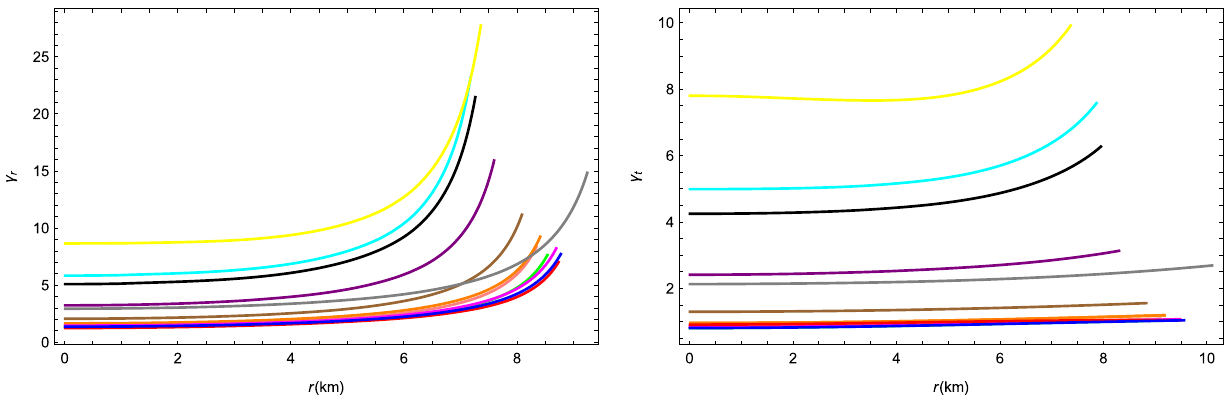
Fig. 10 Variation of γ r , and γ t of S 1 ( (cid:2) ), S 2 ( (cid:2) ), S 3 ( (cid:2) ), S 4 ( (cid:2) ), S 5 ( (cid:2) ), S 6 ( (cid:2) ), S 7 ( (cid:2) ), S 8 ( (cid:2) ), S 9 ( (cid:2) ), S 10 ( (cid:2) ), S 11 ( (cid:2) ), S 12 ( (cid:2)